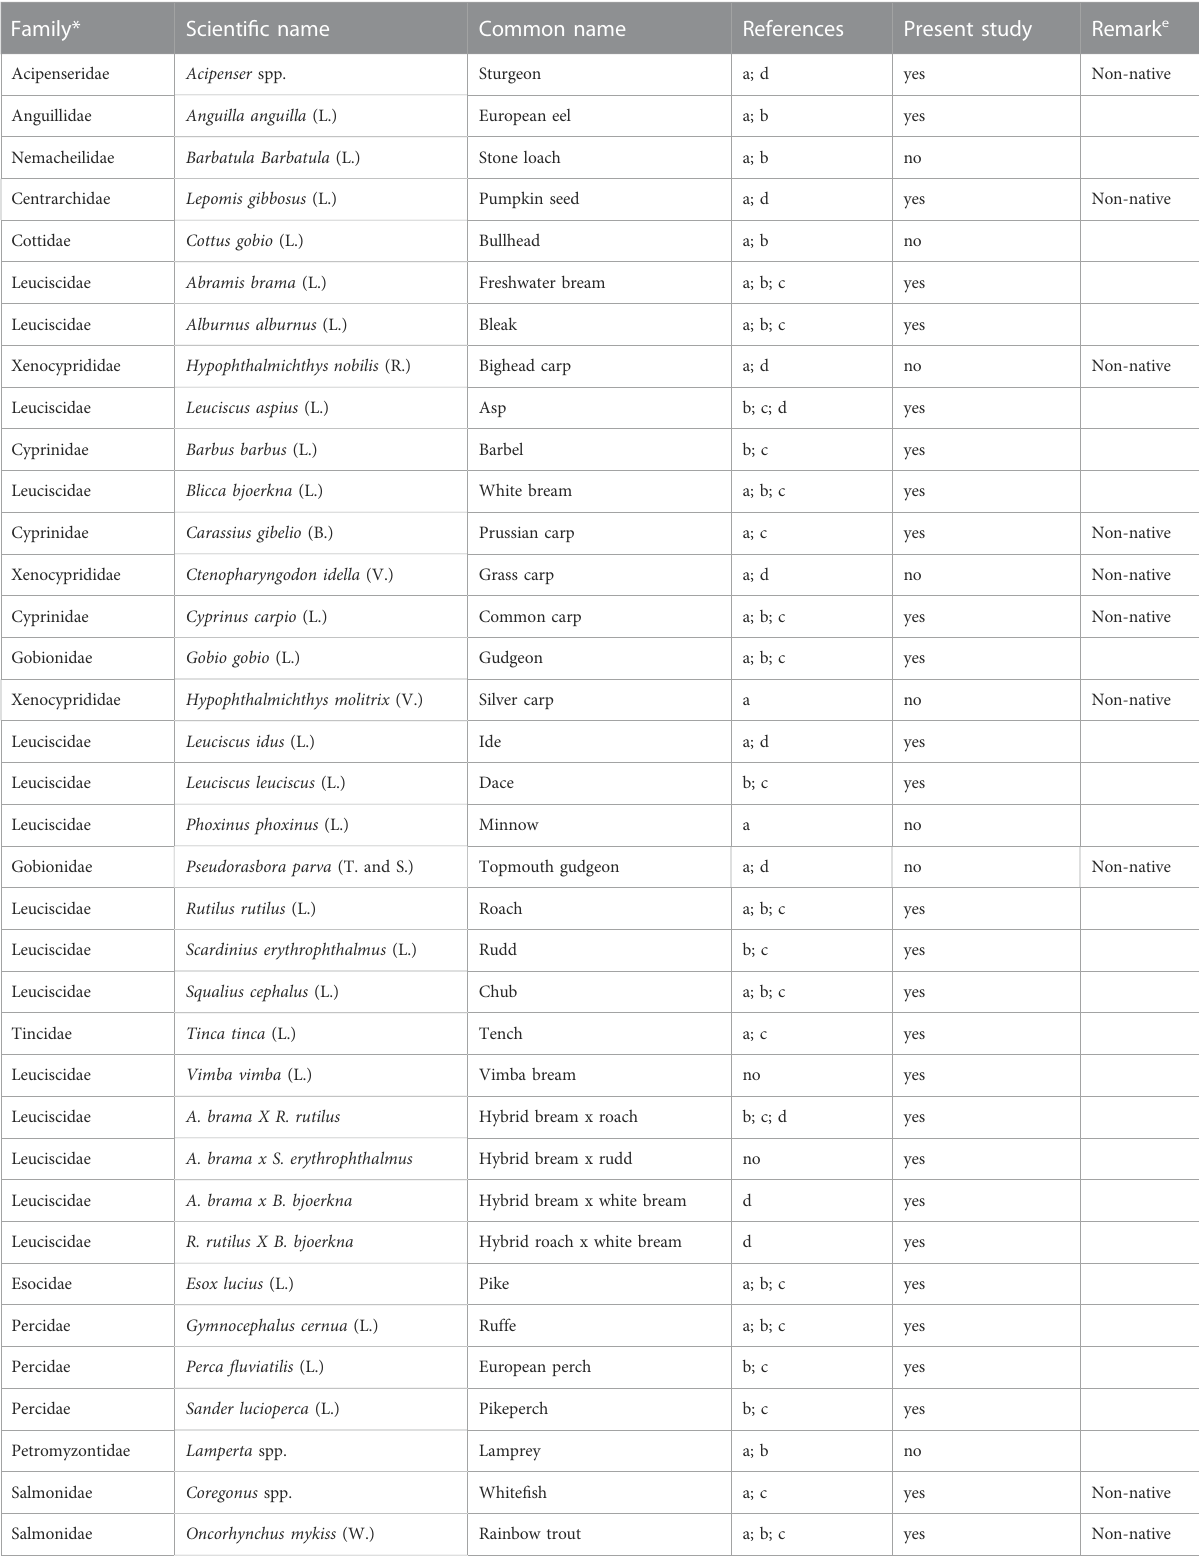
TABLE1Listof fi shspeciesandtheirhybridsknowntooccurandcaughtduringthesamplingperiod(2004 – 2021)in Ř ímovReservoir(CzechRepublic).Species caught, and not caught with the modi fi ed ESG or unreported before indicated with “ yes ” and “ no ” , respectively.